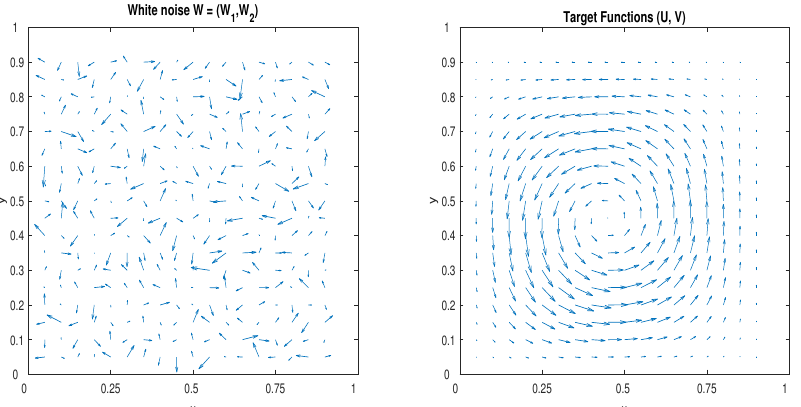
Figure 3. The realization of the white noise ˙W h ( left ) and the target velocity field ( right ) on 18 2 mesh ( h = 1/18).